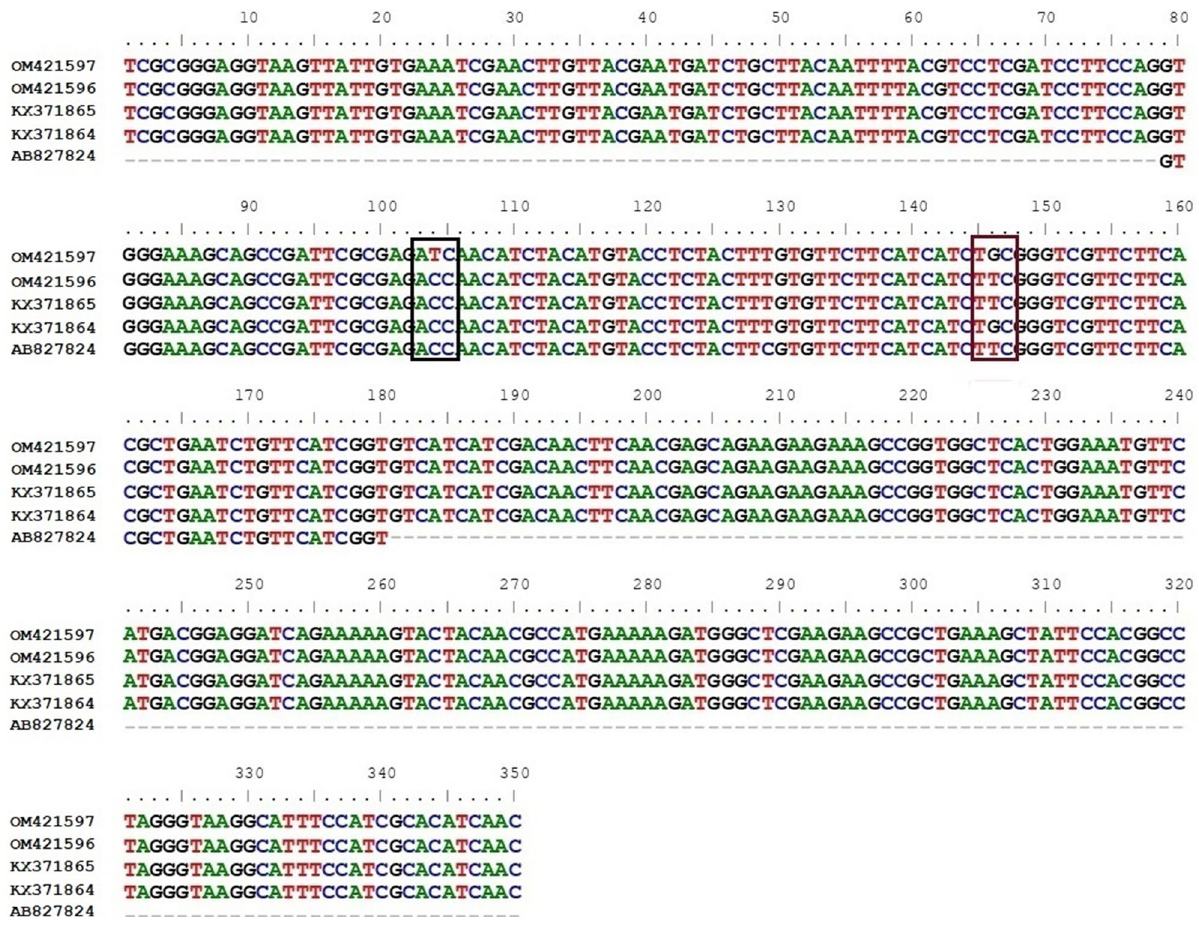
Figure 4. Nucleotide diversity in the IIIS6 vgsc gene sequence of Ae. albopictus from northern part of West Bengal, India. Sequence obtained from the present study (OM421596-OM421597) carried kdr mutation at 1520 and 1534 codon of IIIS6 vgsc gene, as shown black and red colour rectangular respectively. The alignment includes genomic DNA sequences of both F and C at 1534 position [1534Phe (AB827824), 1534Phe (KX371864) and 1534Cys (KX371865)] of IIIS6 vgsc gene, obtained from GenBank